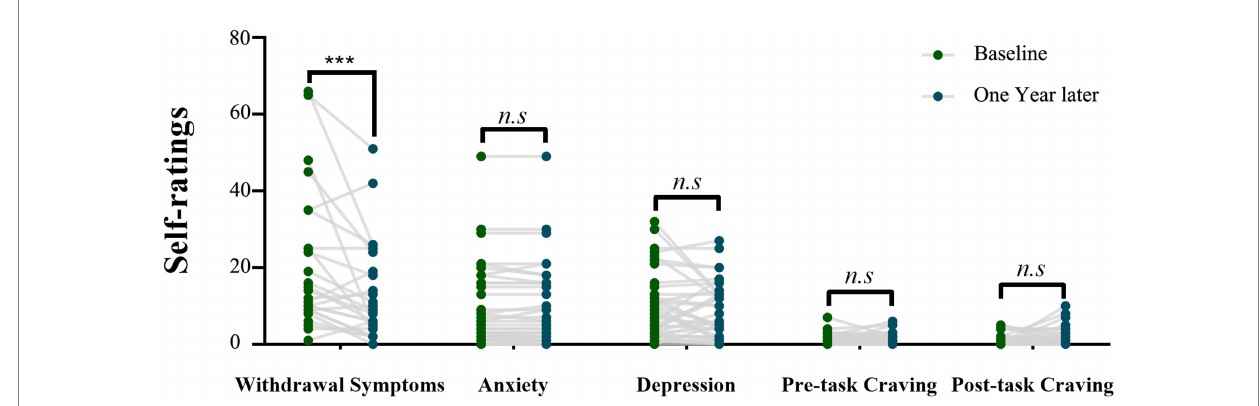
FIGURE 2 The scores of psychological variables of the individuals with HUD at the Baseline and 1 year later. Comparison between the two time points by using the paired-sample t -test (*** p =